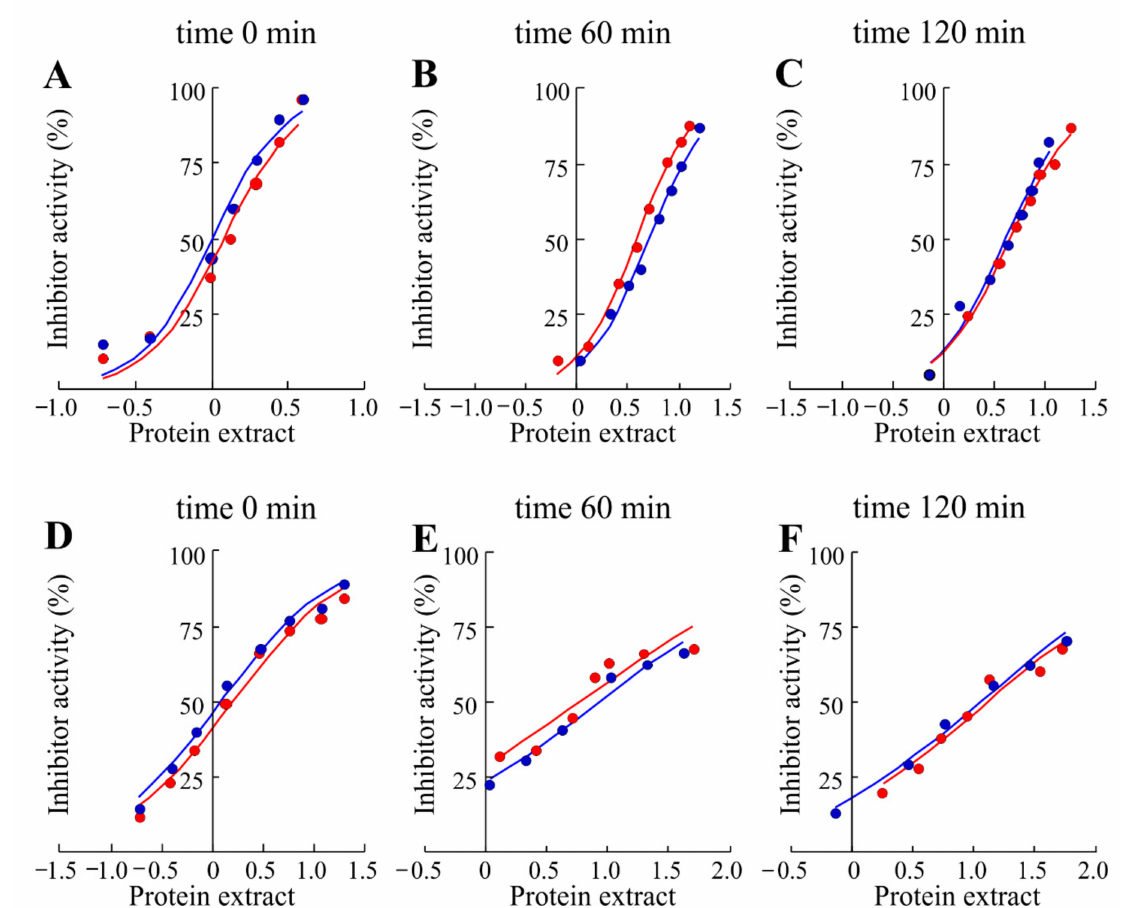
Figure 4. Inhibition curves of trypsin and α -chymotrypsin by raw soluble protein extract obtained from Valle Agricola chickpeas ( A , D , respectively) or cooked Valle Agricola chickpeas at 60 ( B , E , respectively) and 120 min ( C , F , respectively). Increasing concentrations of raw protein extract were added to a fixed concentration of enzymes as indicated in Material and Methods.